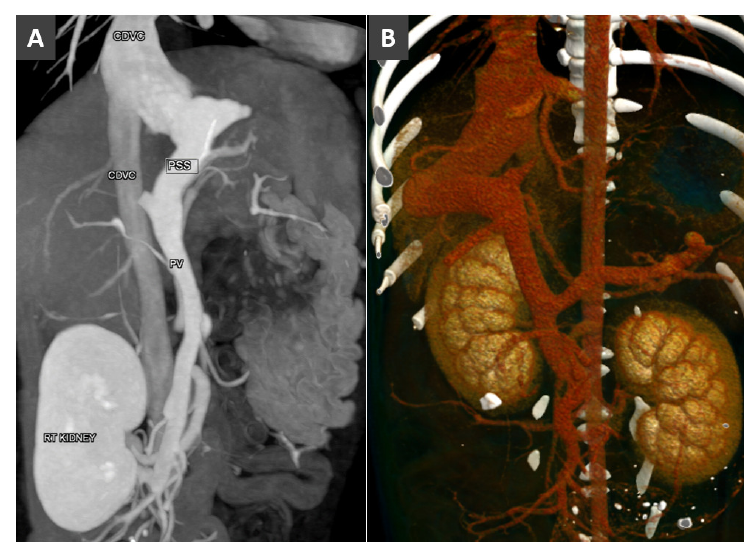
Figure 11. ( A ). Dorsal MIP in a dog with left-sided intrahepatic portosystemic shunt. ( B ). Volume rendered image (ventral view) in a dog with right-sided intrahepatic portosystemic shunt.